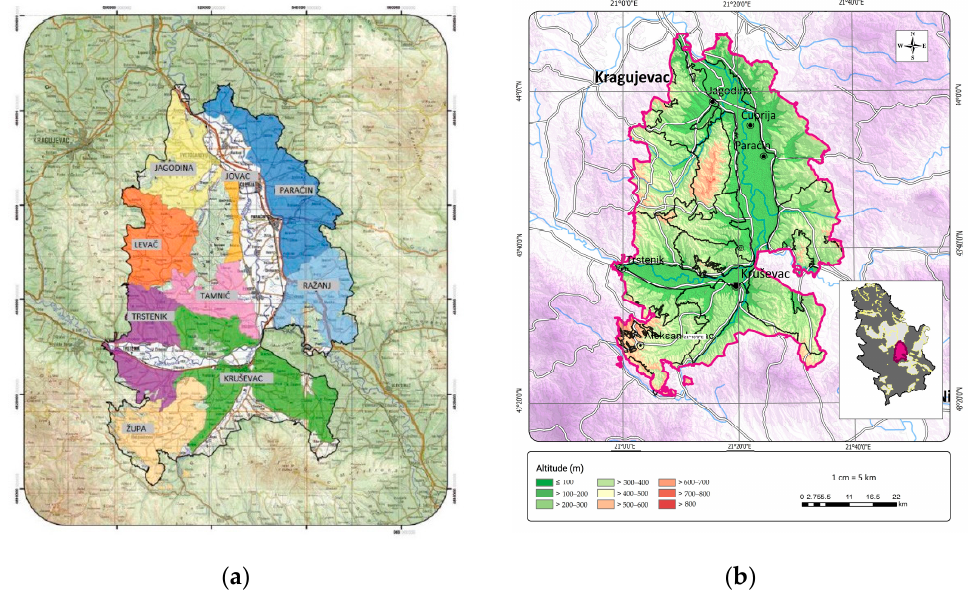
Figure 1. The vineyard region Tri Morave, Serbia: ( a ) vine growing districts (modified by authors) [36] and ( b ) topographic map.